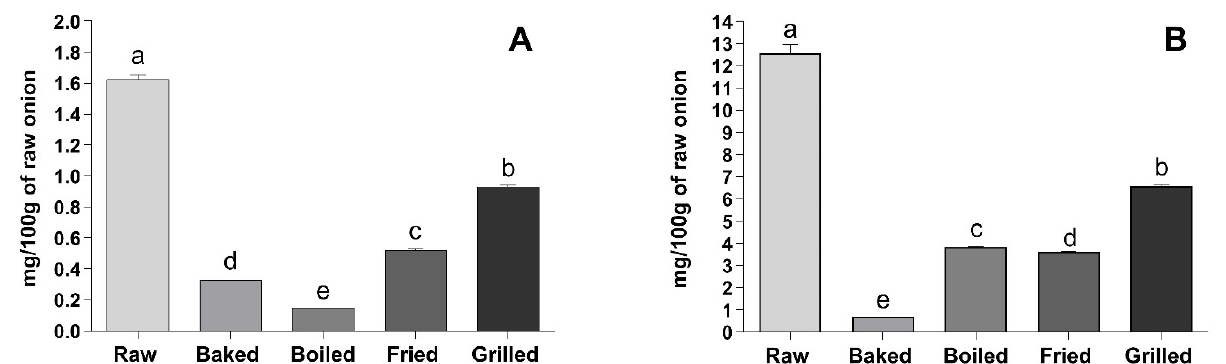
Figure 2. Effect of different cooking methods on YSO hydroxycinnamic acids and RSO anthocyanins referred to the original fresh weight. ( A ) Total hydroxycinnamic acids measured by mass spectrometry in YSO. Results are expressed as mg/100 g of fresh weight. ( B ) Total anthocyanins measured by mass spectrometry in RSO. Results are expressed as mg/100 g of fresh weight. Different letters indicate that the values are significantly different ( p < 0.05).